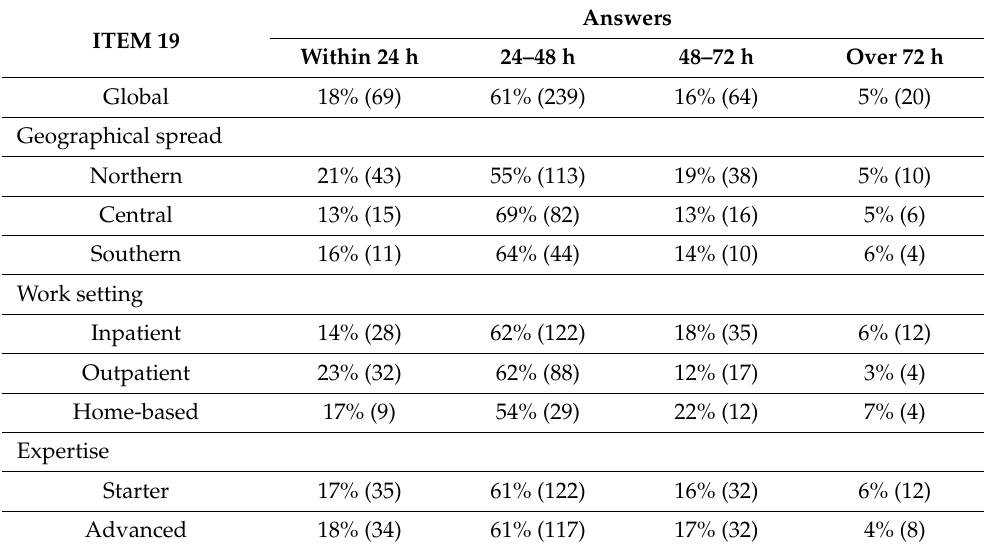
Table 8. Answers referred to item 19: How long does it take for a patient to be verticalized after surgery for a hip